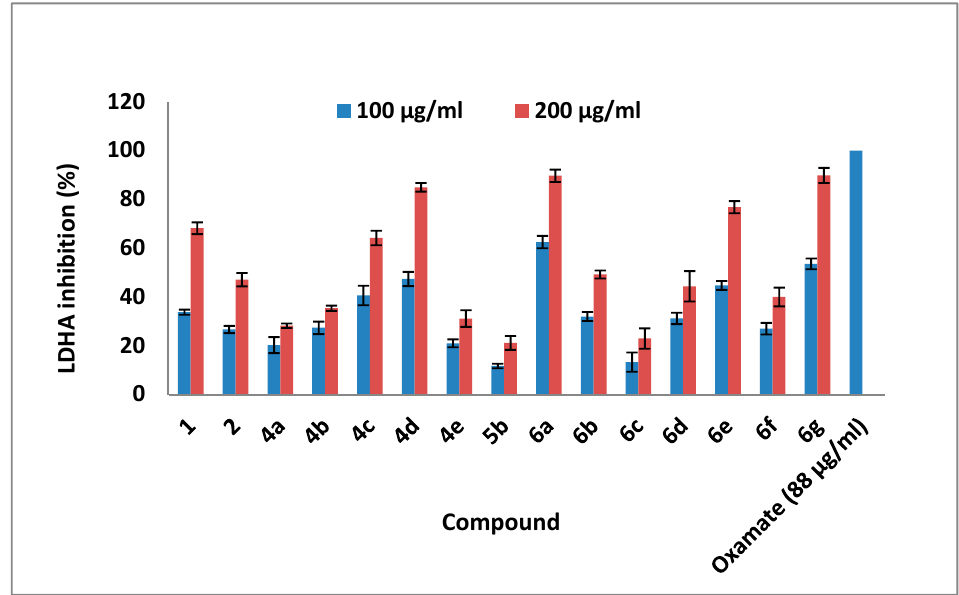
Figure 3. Evaluation of the LDHA inhibitory properties of the synthesized quinoxalinone and quina- zolinone derivatives by the determination of the mean inhibition efficiency at 100 and 200 µ g/mL